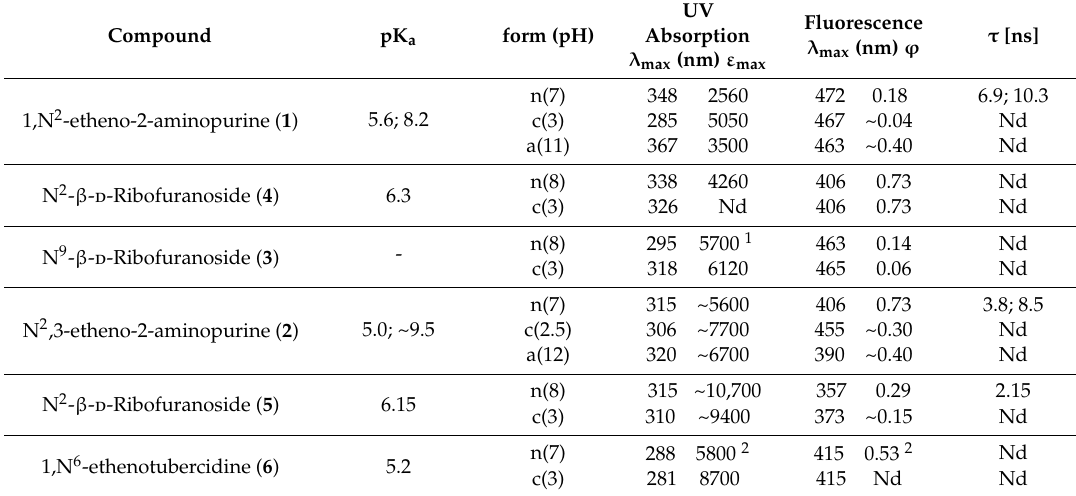
Table 1. Ionization constants (pK a values, determined spectrophotometrically) and spectral parameters for neutral and ionic forms of the investigated compounds (n—neutral form; c—cation; a—anion) . Nd = not determined.